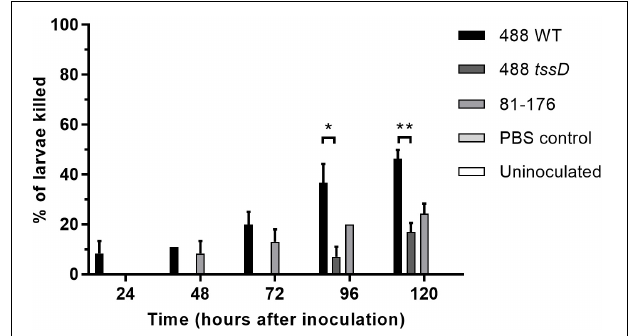
FIGURE 5 | Infection of Galleria mellonella larvae with the 488 wild-type strain, 488 tssD mutant or 81–176 wild-type strain. Ten G. mellonella larvae were injected per bacterial strain with a syringe in the right foremost leg. Controls injected with PBS only were included along with uninoculated controls. Larvae were incubated at 37 ◦ C with counts of dead larvae recorded every 24 h over a period of 5 days. Asterisks denote a statistically significant difference ( ∗ p ≤ 0.05, ∗∗ p ≤